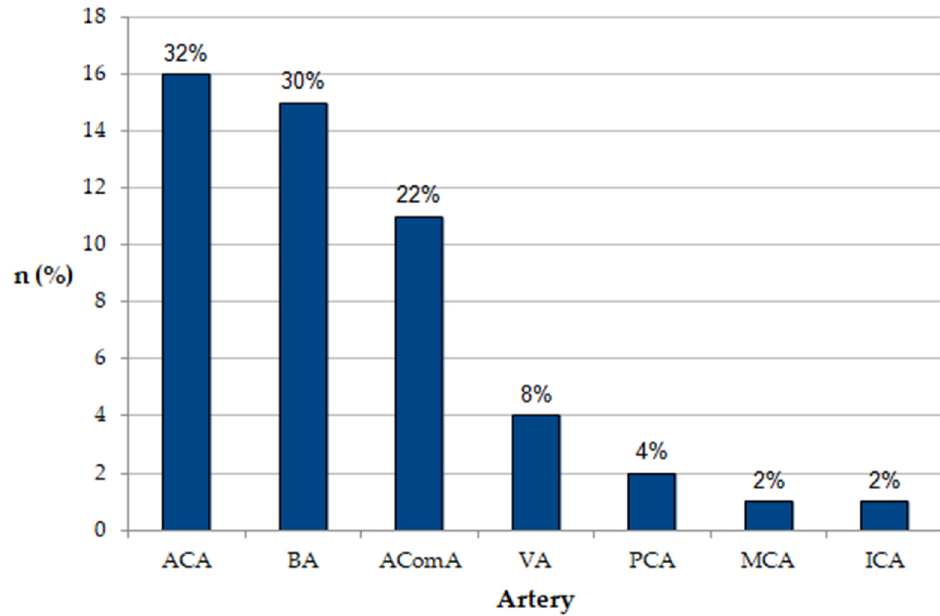
Figure 2. Incidence of fenestration by arteries. In one case, patient possessed two fenestrations, both on ACA. Abbreviations: ACA—anterior cerebral artery, BA—basilar artery, AComA—anterior communicating artery, VA—vertebral artery, PCA—posterior cerebral artery, MCA—middle cerebral artery, ICA—internal carotid artery.